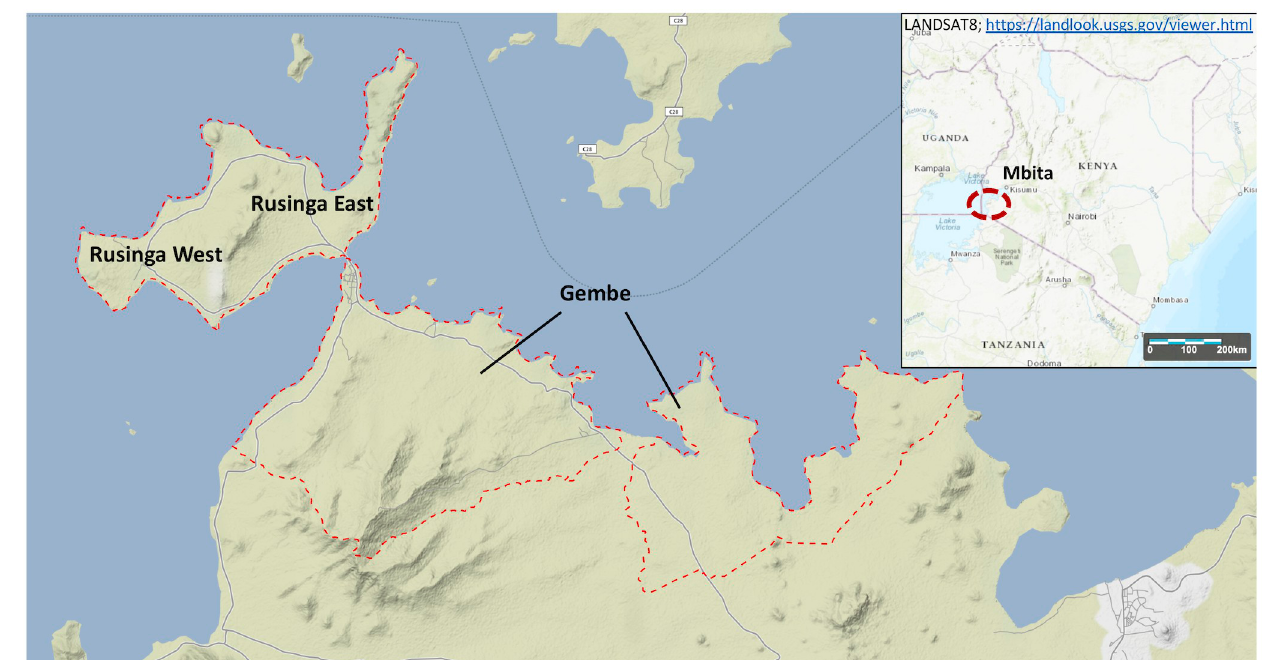
Fig 1. Study site in Mbita, Western